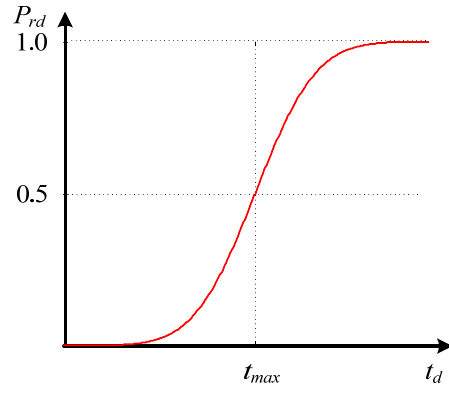
Figure 7. Refuse-operation probability for consistent